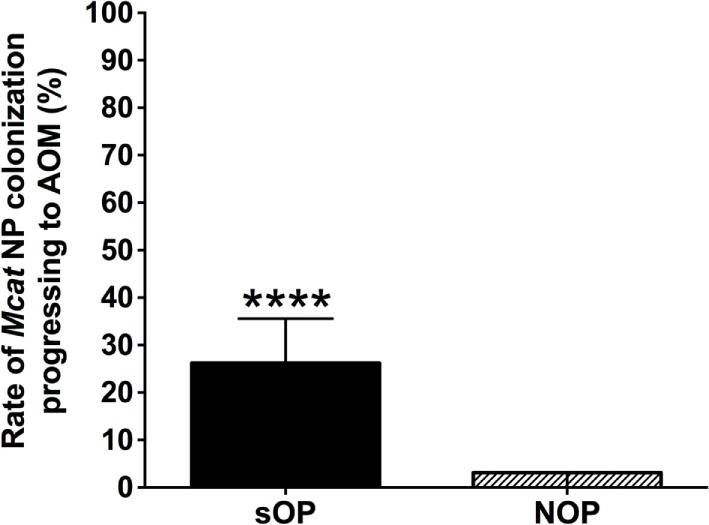
Rates of Moraxella catarrhalis (Mcat) nasopharyngeal (NP) colonization progressing to acute otitis media (AOM) in stringently defined otitis prone (sOP) and non-otitis prone (NOP) children. Rates of Mcat NP colonization progressing to Mcat-caused AOM were assessed for 47 sOP and 61 NOP children age 6–36 months old. Data are represented as percentage ± 95% confidence interval (CI). Ninety five percent CI (error bar) for NOP children cannot be calculated by Fisher’s exact test due to only four (less than five) episodes of Mcat NP colonization progressing to AOM in NOP children. Fisher’s exact test was used to compare the difference in the rates between sOP and NOP children. ****P < 0.0001 comparing sOP vs. NOP children.